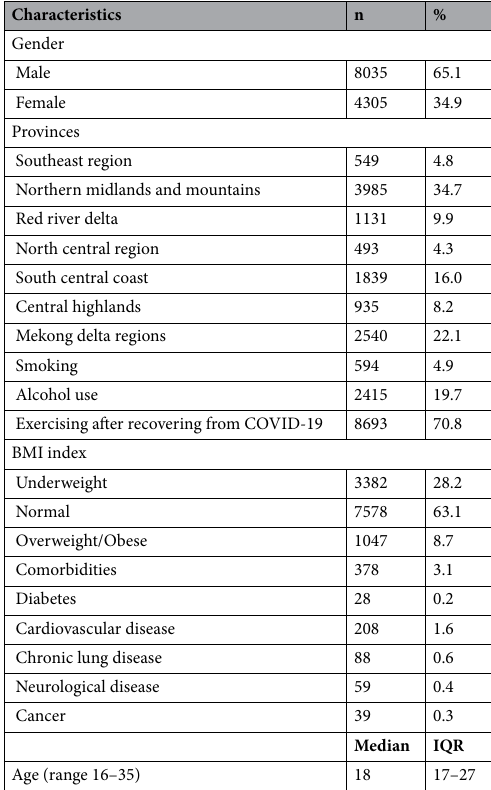
Table 1. Individual characteristics of